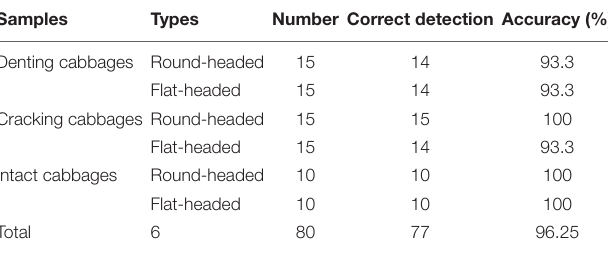
TABLE 2 | Detection results of point cloud defect detection